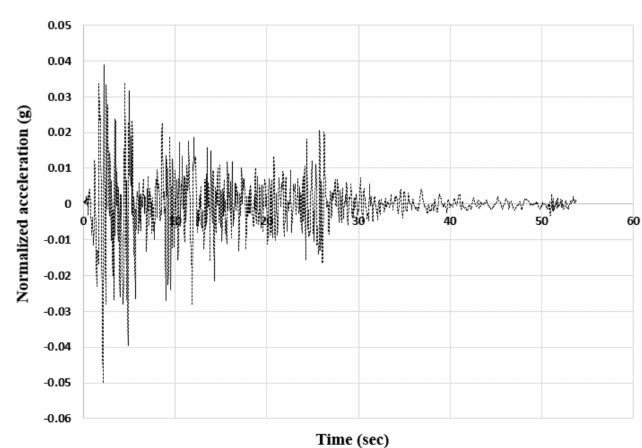
Figure 16. Normalized acceleration of the Pohang earthquake.